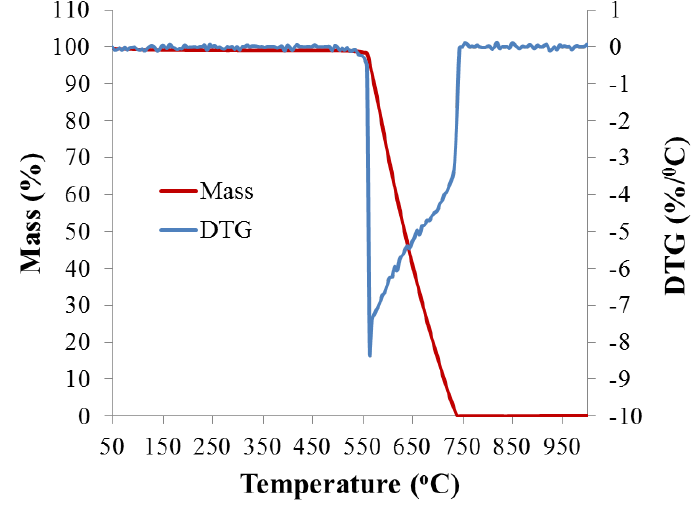
Figure 6. Thermal stability determined by TPO analysis. The sample maintains its weight up to at least 550 °C under an oxygen containing atmosphere, after such the carbon starts to burn off until only the weight of the original palladium catalyst particles, now oxidized, remains.